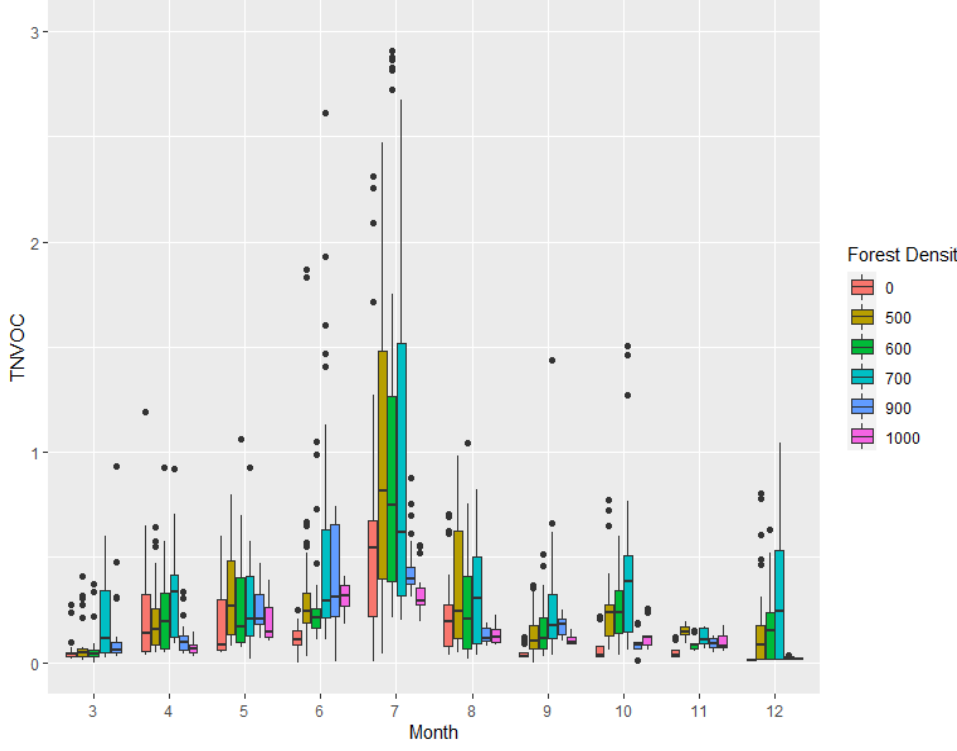
Figure 4. Boxplot of monthly TNVOC ( μ g/m 3 ) emissions according to forest density.